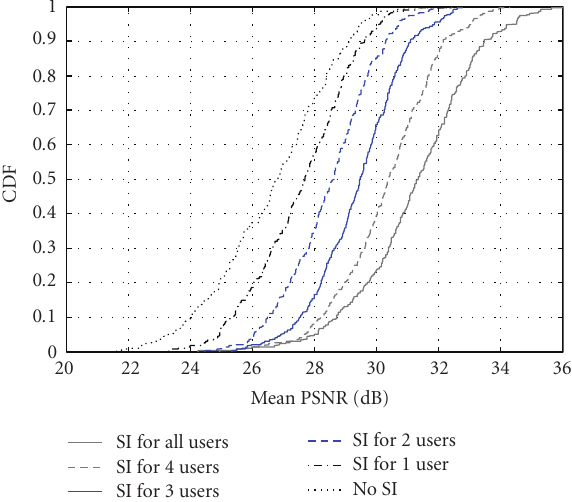
Figure 17: CDF of mean PSNR (in dB) for a five-user video stream- ing